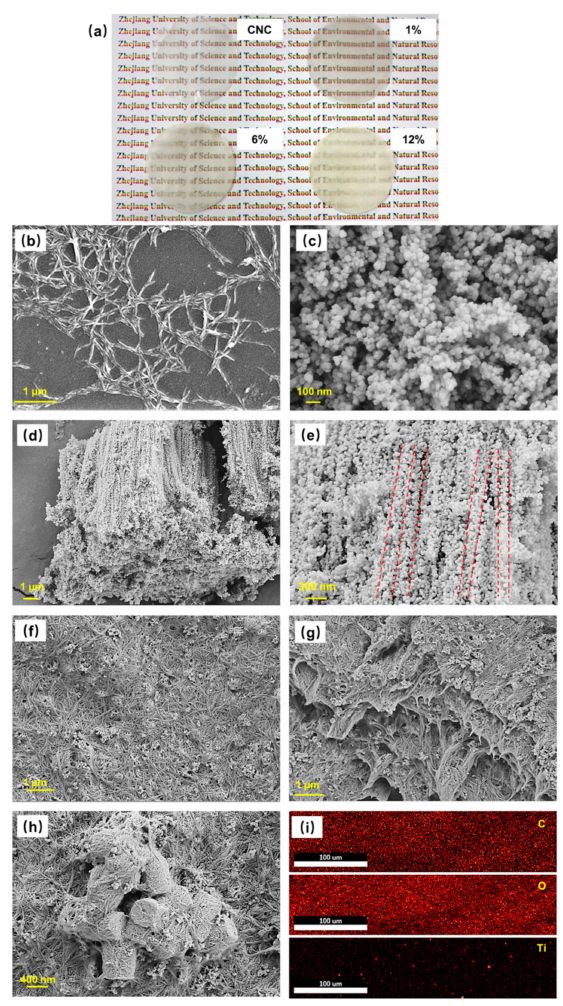
Figure 2. ( a ) Pictures of TiNP/CNC composite films with different TiNP content. Scanning electron microscopy (SEM) images of ( b ) cellulose nanocrystals (CNC), ( c ) spherical titanium dioxide (TiO 2 ) nanoparticles (TiNP), ( d , e ) TiO 2 nanotubes, ( f , g ) top view, side view of 6% TiNP/CNC composite film, ( h ) 12% TiNP/CNC composite film. ( i ) SEM elemental mapping images of C, O, and Ti elements of 6% TiNP/CNC composite